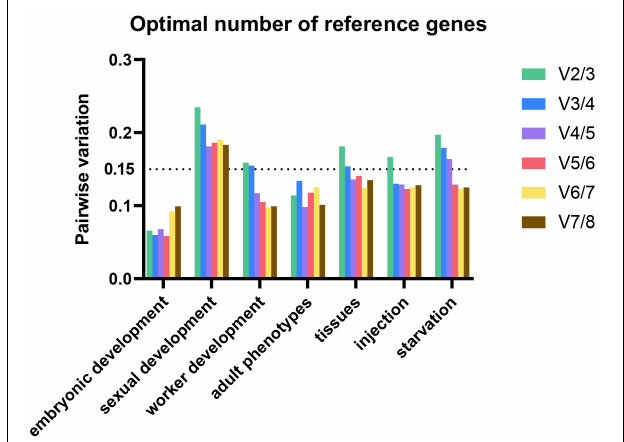
FIGURE 3 | Optimal number of reference genes for normalization in M. pharaonis. The pairwise variation (V n /V n + 1 ) was analyzed between the normalization factors NF n and NF n + 1 by geNorm. Average value of pairwise variations (v) indicates the optimal number of reference genes. The values that above the threshold value of 0.15 means an extra reference gene should add to the stability of the normalization